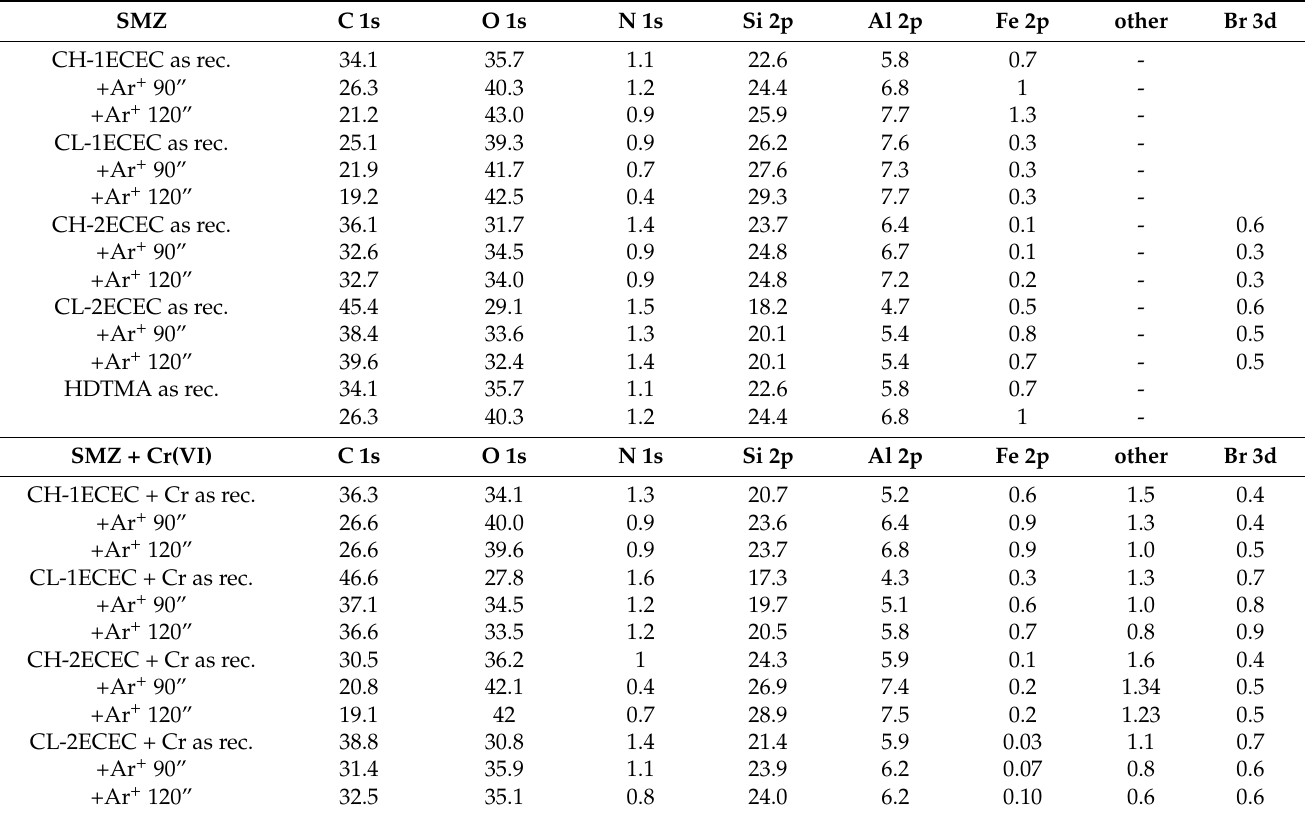
Table 4. XPS elemental composition of analyzed materials (% at.) with different time of Ar + etching. SMZ C 1s O 1s N 1s Si 2p Al 2p Fe 2p other Br 3d CH-1ECEC as rec. +Ar + 90” +Ar + 120” CL-1ECEC as rec. +Ar + 90” +Ar + 120” CH-2ECEC as rec. +Ar + 120” 32.7 CL-2ECEC as rec. +Ar + 120” HDTMA as rec. SMZ + Cr(VI) C 1s O 1s N 1s Si 2p Al 2p Fe 2p other Br 3d CH-1ECEC + Cr as rec. +Ar + 90” +Ar + 120” CL-1ECEC + Cr as rec. +Ar + 90” +Ar + 120” CH-2ECEC + Cr as